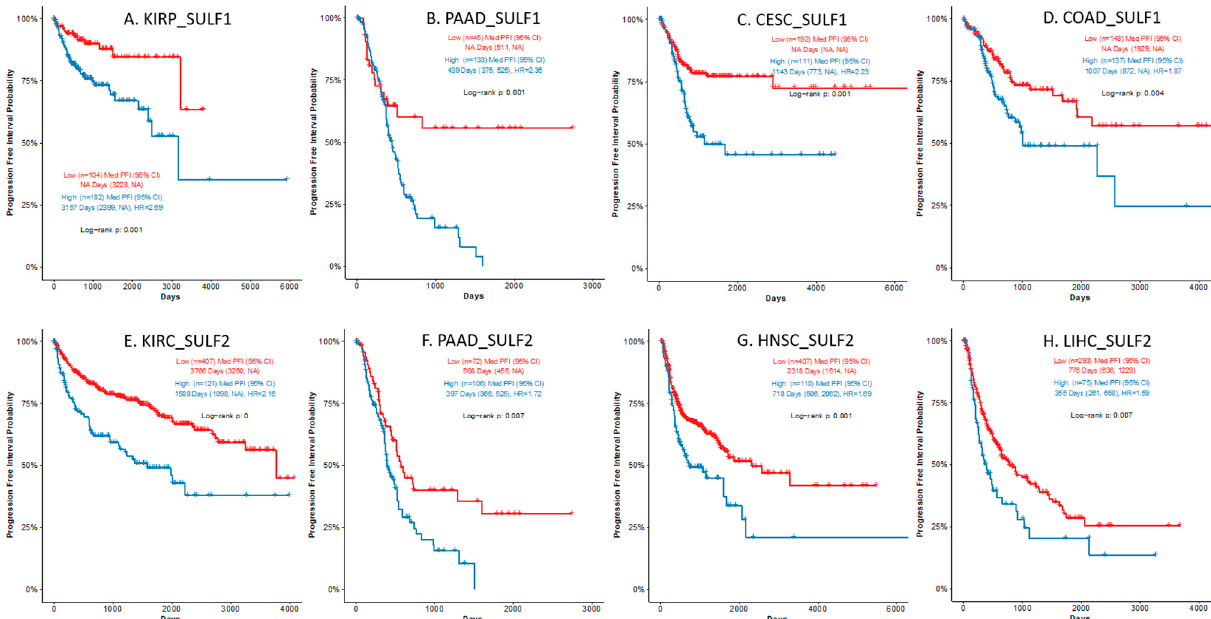
Figure 2. SULF1 and SULF2 expressions in tumor tissues are associated with poor survival. High SULF1 ( A – D ) or high SULF2 ( E – H ) expression is significantly (HR > 1.5, FDR < 0.05) associated with poor progression-free interval (PFI) in the following TCGA cancer studies: ( A ). KIRP, ( B ). PAAD, ( C ). CESC, ( D ). COAD for SULF1; and ( E ). KIRC, ( F ). PAAD, ( G ). HNSC, and ( H ). LIHC for SULF2.